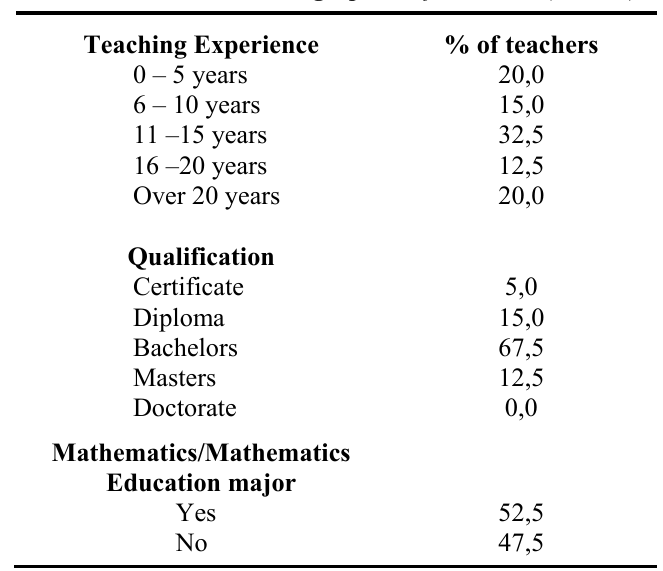
Table 1 : Teachers’ demographic information (N = 40)